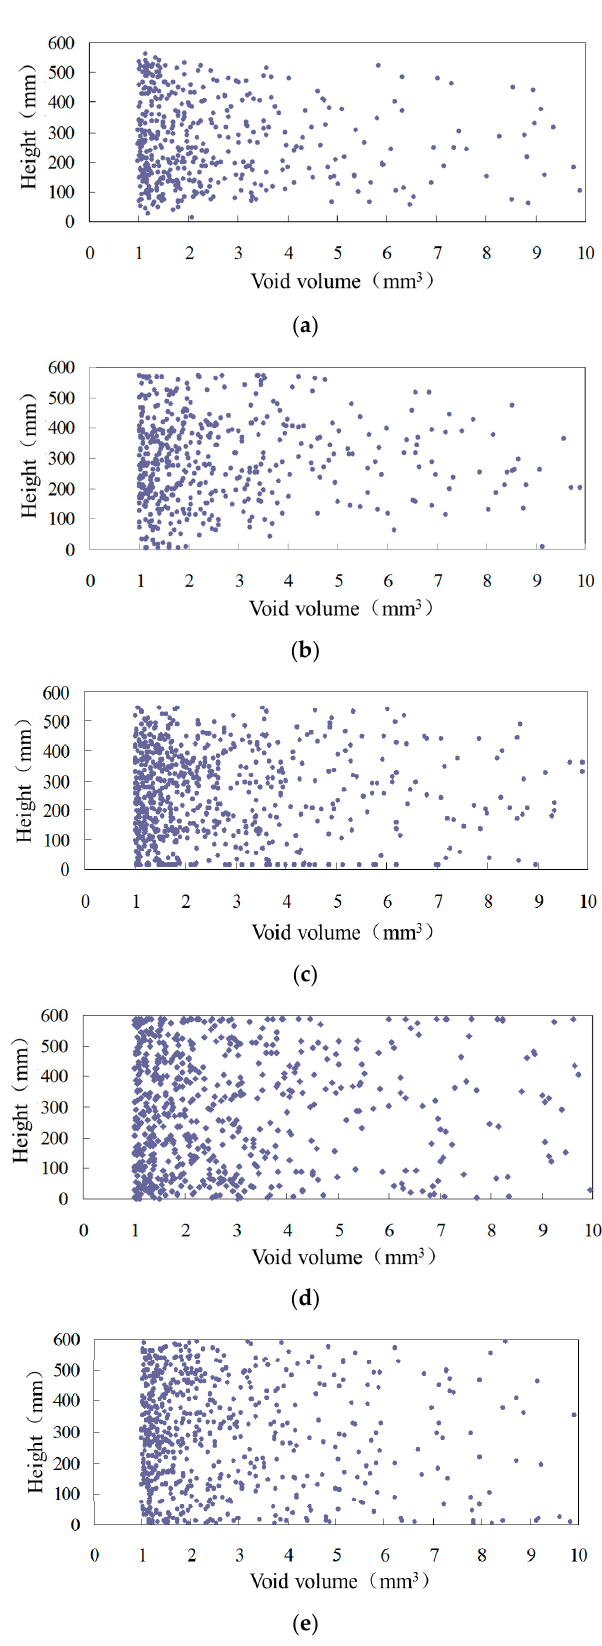
Figure 5. 1–10 mm 3 void distribution of asphalt mixture. ( a ) 80 ◦ C; ( b ) 90 ◦ C; ( c ) 120 ◦ C; ( d ) 140 ◦ C; ( e ) 150 ◦